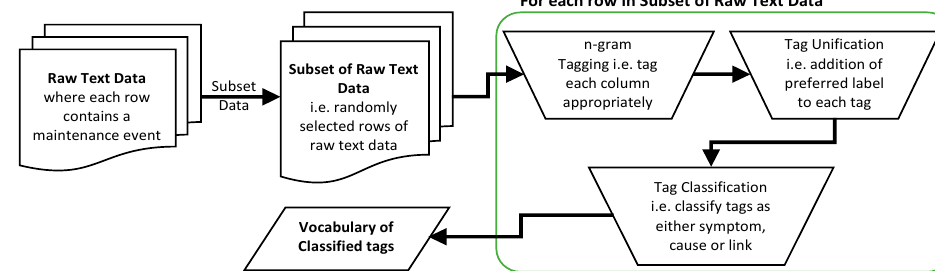
Figure 2. Expert annotation step flowchart.